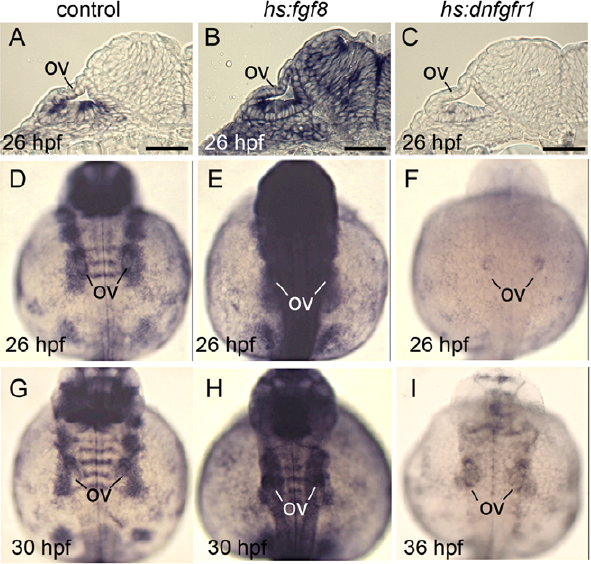
Figure 3. Effects of transgene activation on expression of the Fgf reporter etv5b . All embryos were heat shocked for 30 minutes beginning at 24 hpf. Wild-type and hs:fgf8 embryos were heat shocked at 39 u C and hs:dnfgfr1 embryos were heat shocked at 38 u C. (A–C) Cross sections showing etv5b expression in wild-type (A), hs:fgf (B) and hs:dnfgfr1 (C) embryos at 26 hpf. (D–I) Dorsal views (anterior up) of wholemounts showing etv5b expression in wild-type (D, G), hs:fgf8 (E, H) and hs:dnfgfr1 (F, I) embryos at the indicated times. The otic vesicle (ov)